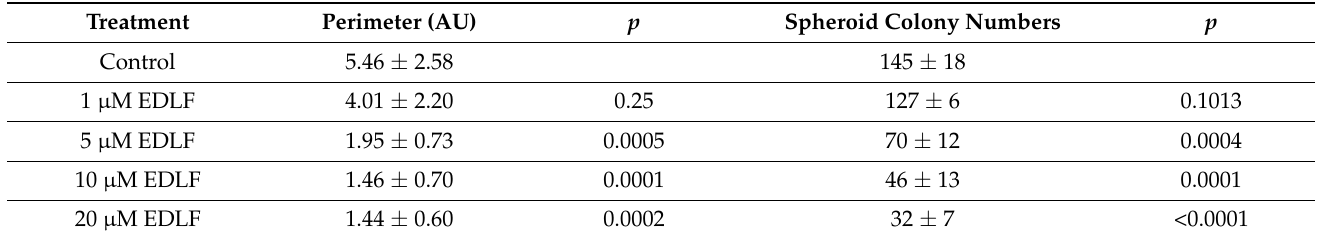
Table 2. Effect of edelfosine on the formation of pancreatic CSC spheroid colonies. Treatment